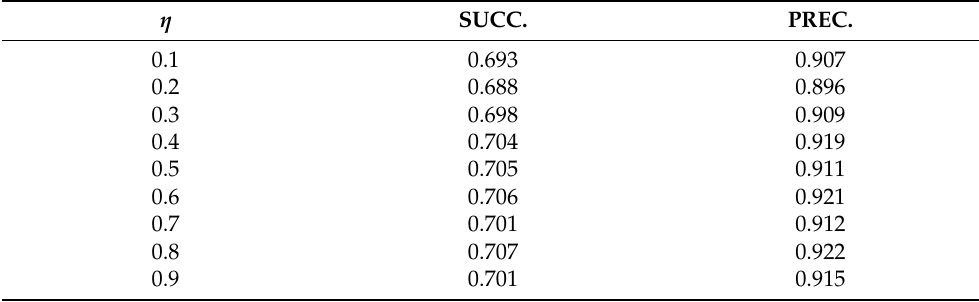
Table 6. The comparative results of success and precision using different weights. η SUCC.